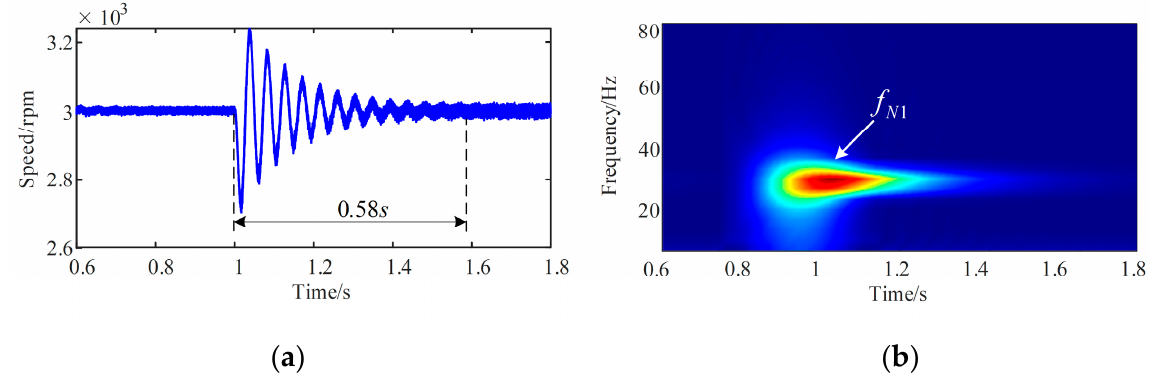
Figure 16. Motor 1 speed: ( a ) time domain; ( b ) time-frequency domain (0–80 Hz).